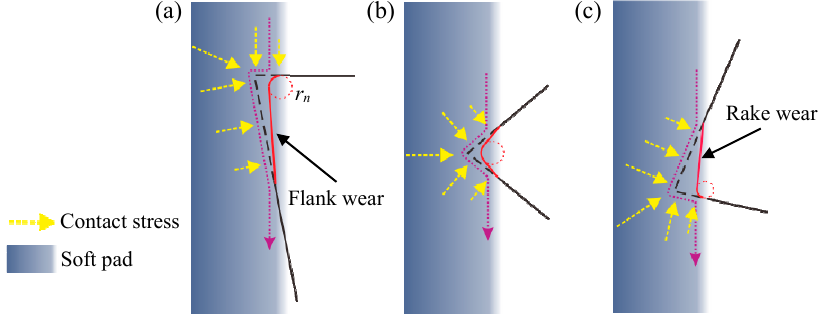
Figure 12. Schematic diagram of the material removal mechanism in tool-edge passivation process at different depression angles: ( a ) 0°; ( b ) 45°; ( c ) 60°.